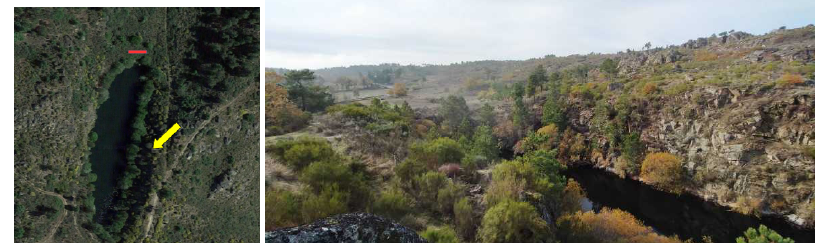
Figure 17. Local B: an old uranium mine. ( left ) Satellite view. ( right ) Ground-level photograph. The third scenario—Local C—is an olive groove, with sparse trees, ranging from 50 cm to 4 m in height. Trees are separated by 3 m or more. A satellite view is shown on the left of Figure 18, and a ground-level picture is shown on the right. The ground is plowed, with only dirt and trees. The terrain is sloped but easy to walk. The map of the ground radiation was not known, but public agencies knew that there is natural radiation above background levels.